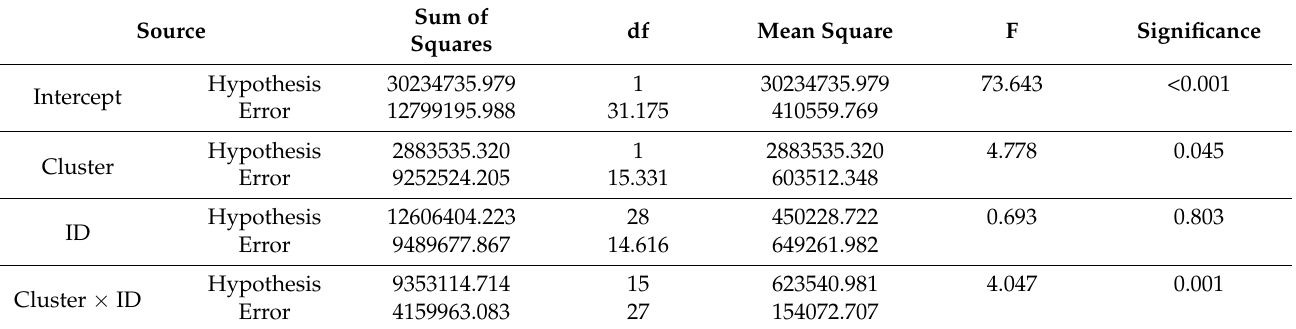
Cluster: foraging clusters; ID: identification number of the individuals; df: degree of freedom.